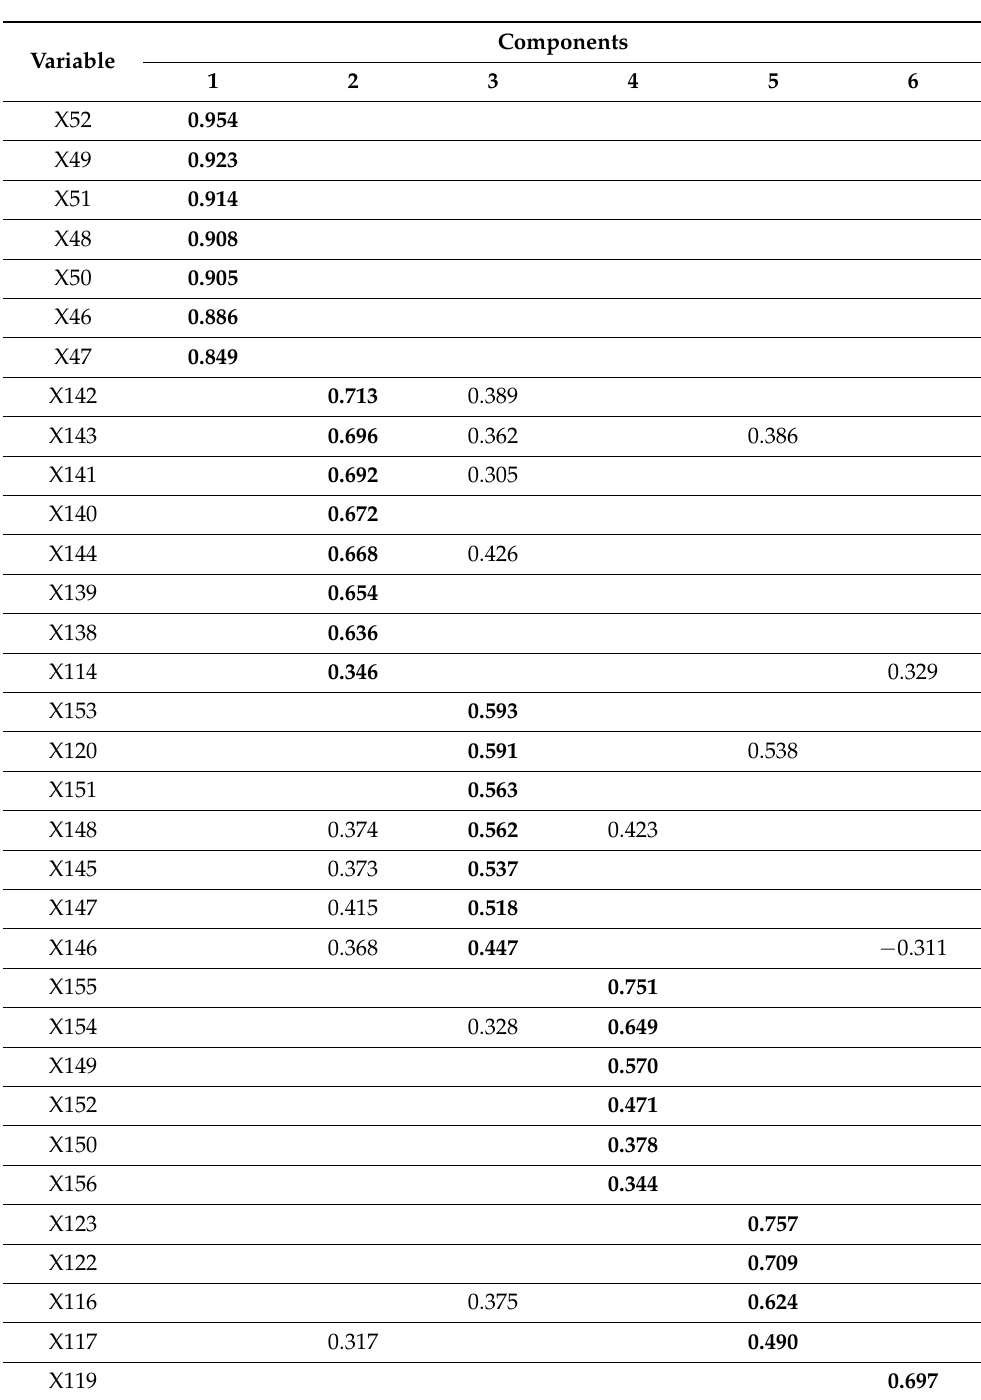
Table 4. Rotated Structure Matrix after